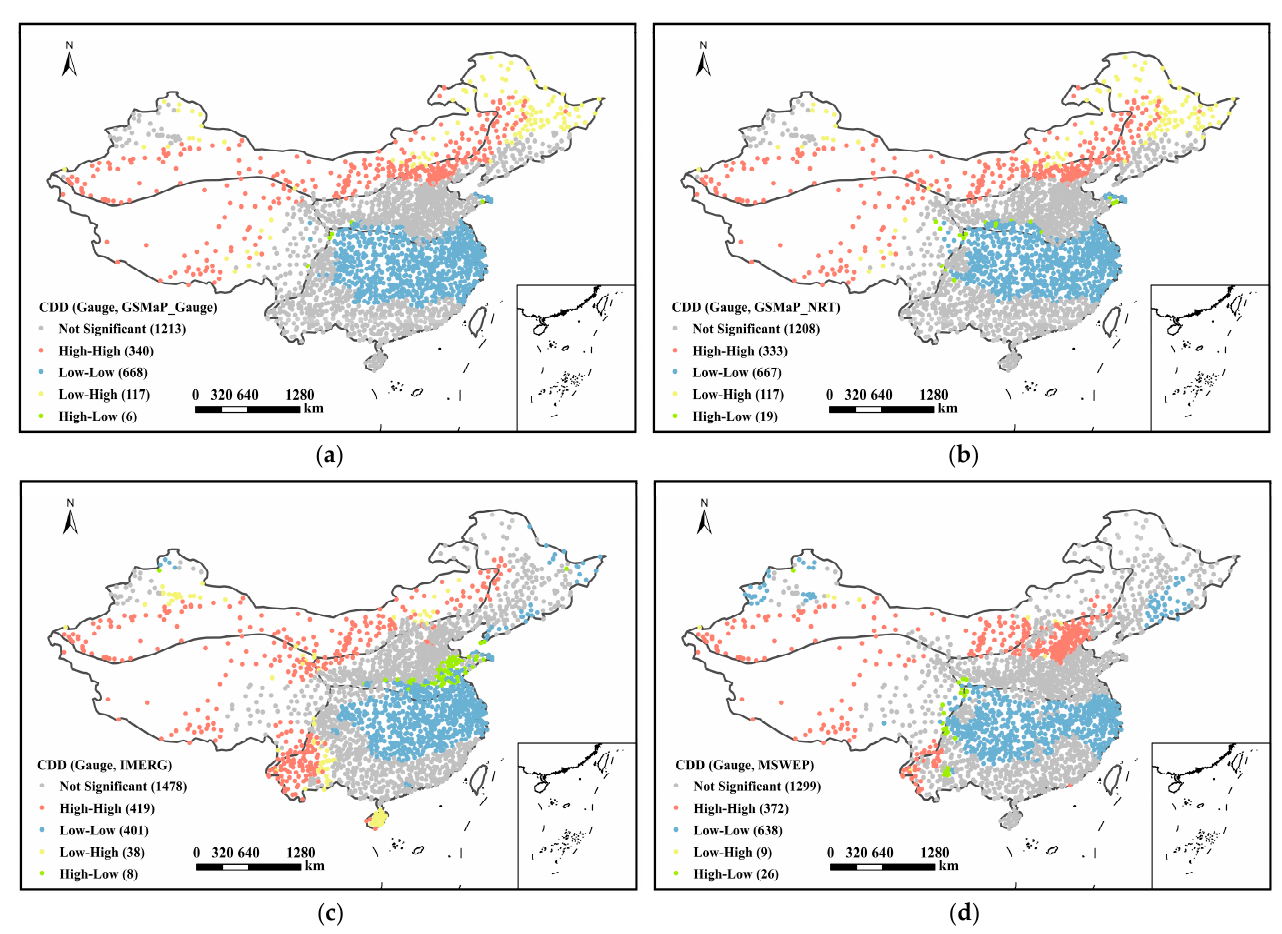
Figure 8. The LISA cluster maps of CDD between the gauge observations and the four SPPs and the number in the bracket signify represent the corresponding number of gauges: ( a ) GSMaP_Gauge, ( b ) GSMaP_NRT, ( c ) IMERG, and ( d )